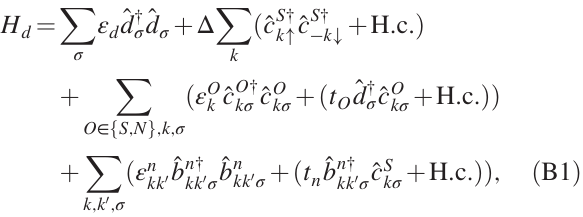
FIG. 8. Top panel: Measured amplitude A versus V already shown in Fig. 4(c). Bottom panels: Measured conduct- ance G (black dots), and cavity signals Δ φ (blue dots) and A (red dots) versus V , along the dashed lines in the top panel, for g 0 . 25 , 0.303, and 0.336 mV from left to right. The solid red, V b ¼ blue, and black lines show the predictions given by Eqs. (3), (6), and (B17), for the same parameters as in Fig. 4. The areas in the gray rectangles are enlarged in Fig. 5 of the main